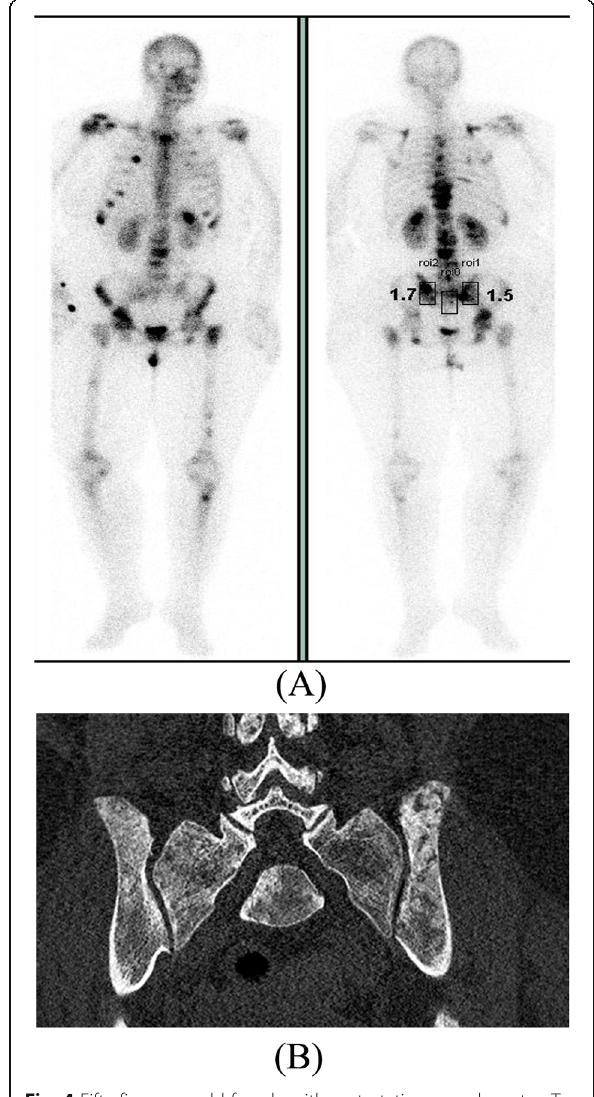
Fig. 4 Fifty-five years old female with metastatic cancer breast. a Tc- 99 m MDP whole-body bone scintigraphy (anterior and posterior views) shows multiple regions of increased uptake including both sacroiliac joints (right SII = 1.5, left SII = 1.7). b Coronal MSCT (bone window) shows multiple mixed lytic and sclerotic bony deposits involving both sacroiliac